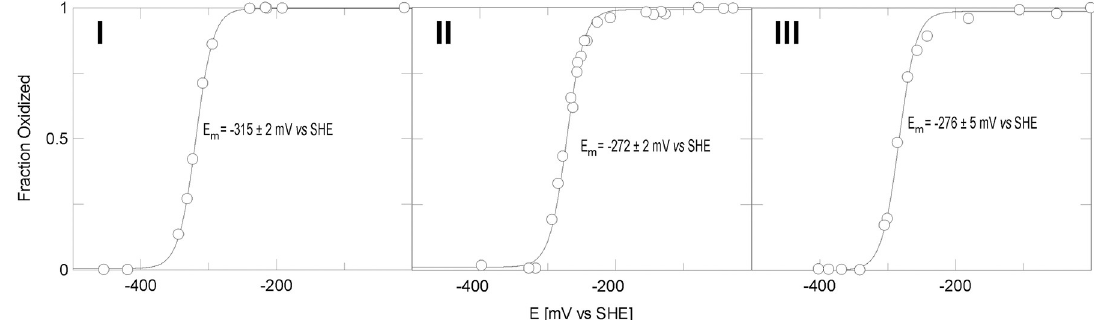
Fig 7. Potentiometric titration of safranines I-III. Line drawn is a fit to Eq 1 with the number of electrons fixed at 2. Errors are errors of the fit.